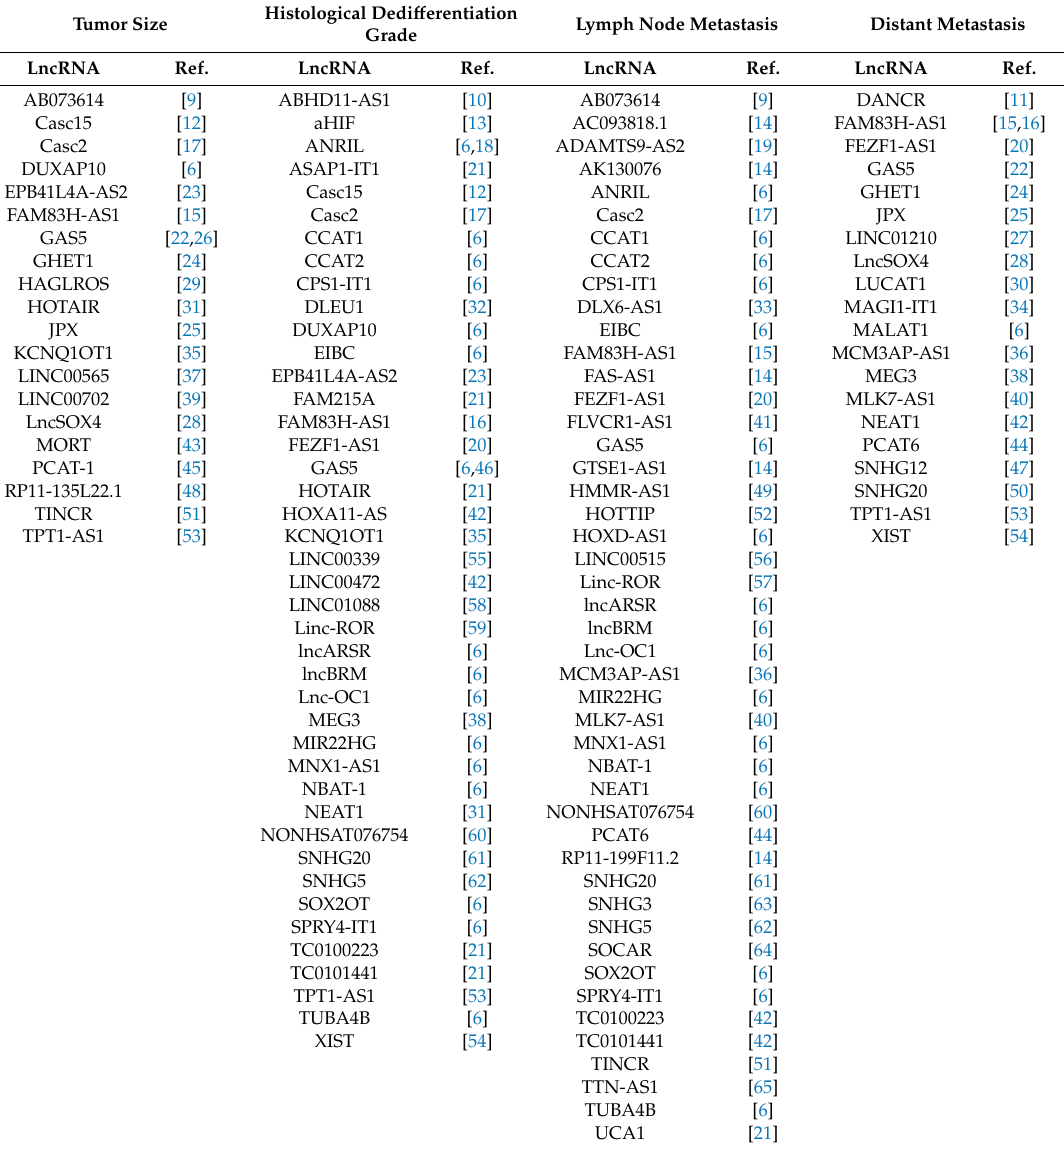
Table 1. Long non-coding RNAs (lncRNAs) associated with clinicopathological variables in ovarian cancer (OC)